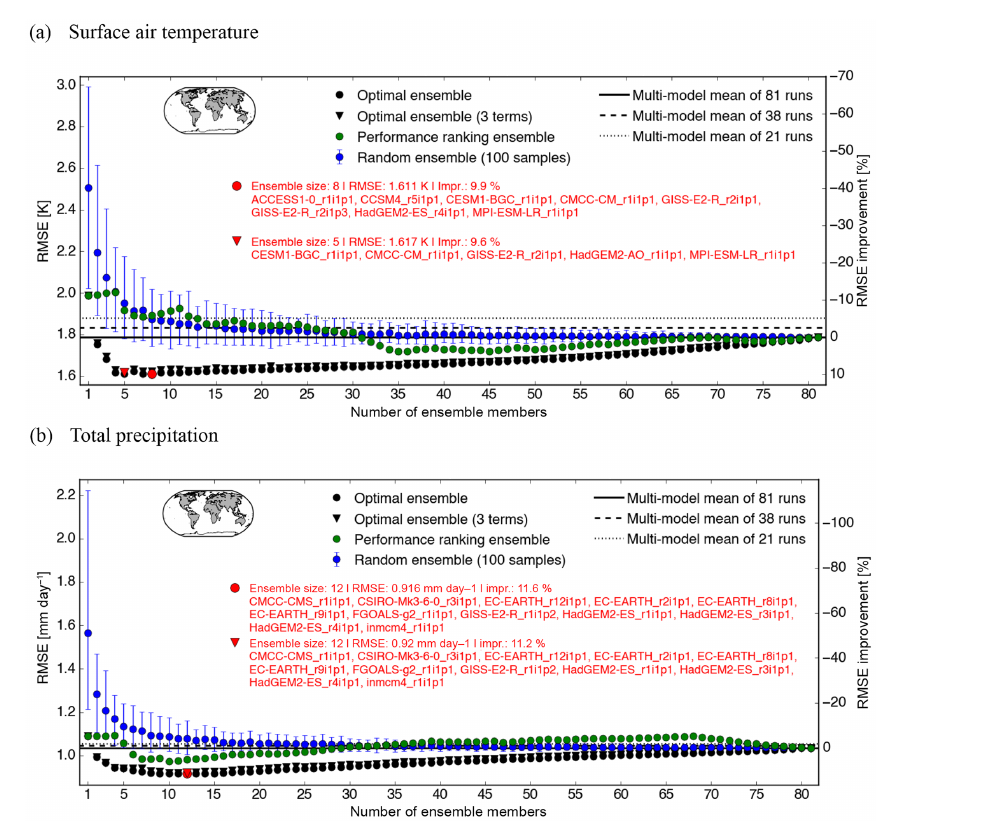
Figure 1. Size of the CMIP5 subset on the horizontal axis and the resulting RMSE of the ensemble mean and its improvement relative to the multi-model mean (MMM) on the vertical axes for surface air temperature (a) , total precipitation (b) , and three different types of ensembles. The RMSE was calculated based on the 1956–2013 climatology of the ensemble mean and the observational product CRUTS3.23. Black dots indicate the values for the optimal ensemble, green dots the ensemble based on performance ranking of individual members, and randomly selected ensembles in blue. For the random ensemble, the dot represents the mean of 100 samples and the error bar is the 90% confidence interval. The red circle indicates the optimal subset size with the overall smallest RMSE compared to the observational product. The model simulations which are part of this optimal subset are listed in red font next to the circle. The black triangles represent the optimal ensembles for a cost function that consists of three terms (see Eq. 2). The corresponding red triangle is the optimal subset of the black triangle cases. The map shows CRUTS3.23 coverage. The solid horizontal line indicates the RMSE value for the MMM of all 81 simulations. For the dashed line, we first average over the members of one model and then average over all 38 models. The RMSE of the mean of 21 simulations (one simulation per institute) is represented with the dotted